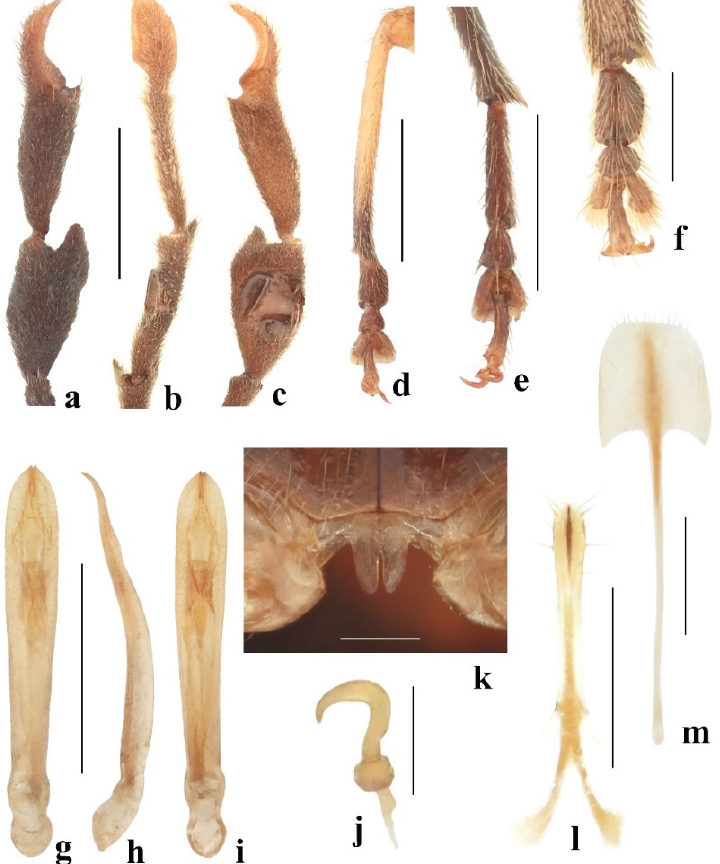
Figure 3. Taumacera cervicornis (Baly, 1861): ( a ) antennomeres X–XII, dorsal view; ( b ) antennomeres X–XII, lateral view; ( c ) antennomeres X–XII, ventral view; ( d ) male mesotibia; ( e ) male metatarsus; ( f ) male mesotarsus; ( g ) aedeagus, dorsal view; ( h ) aedeagus, lateral view; ( i ) aedeagus, ventral view; ( j ) male metasternal process; ( k ) spermatheca; ( l ) gonocoxae; ( m ) sternite VIII. (Scale bars: ( a – e , g – i ) = 1 mm, ( f , l , m ) = 0.5 mm, ( k ) = 0.3 mm, ( j ) = 0.2 mm).